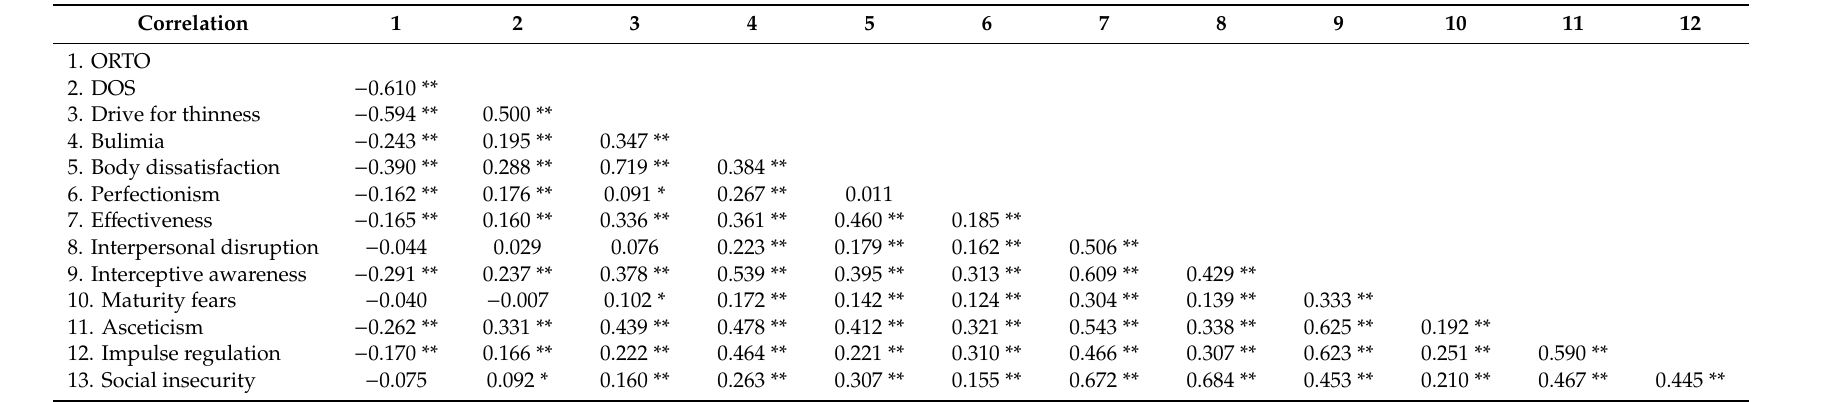
Table 4. Correlation matrix between ORTO, DOS, and EDI-2